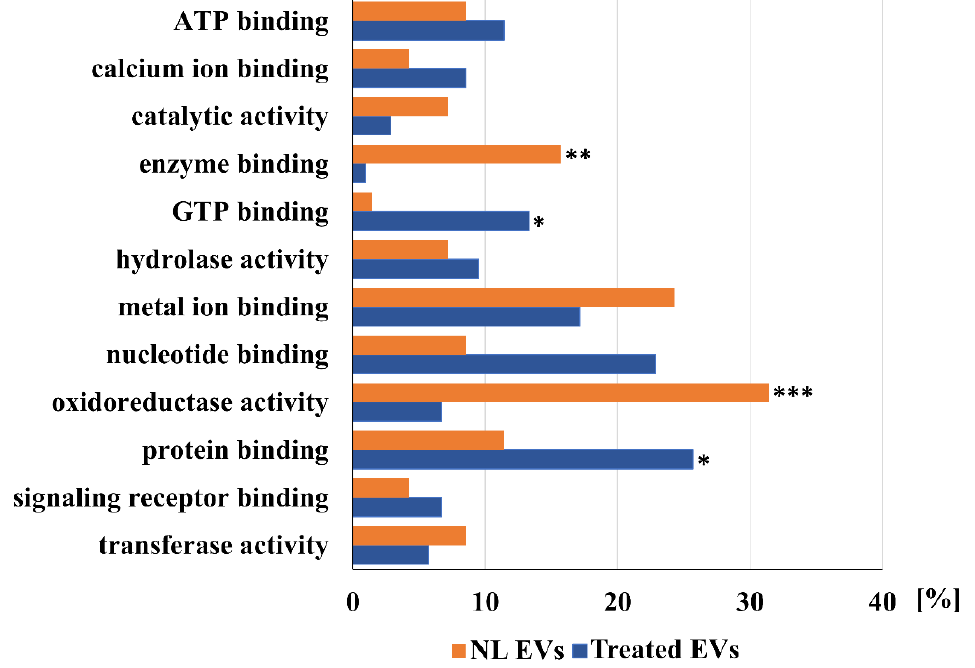
Figure 2. Comparison of unique proteins of normal (NL EVs) and acetaminophen treated (Treated EVs) liver EVs annotated according to their molecular function. For the enrichment of GO terms the threshold was set at the p < 0.001. Statistically significant enriched GO terms are marked according to the obtained p -value: * p < 0.001, ** p < 0.0001, *** p < 0.00001.